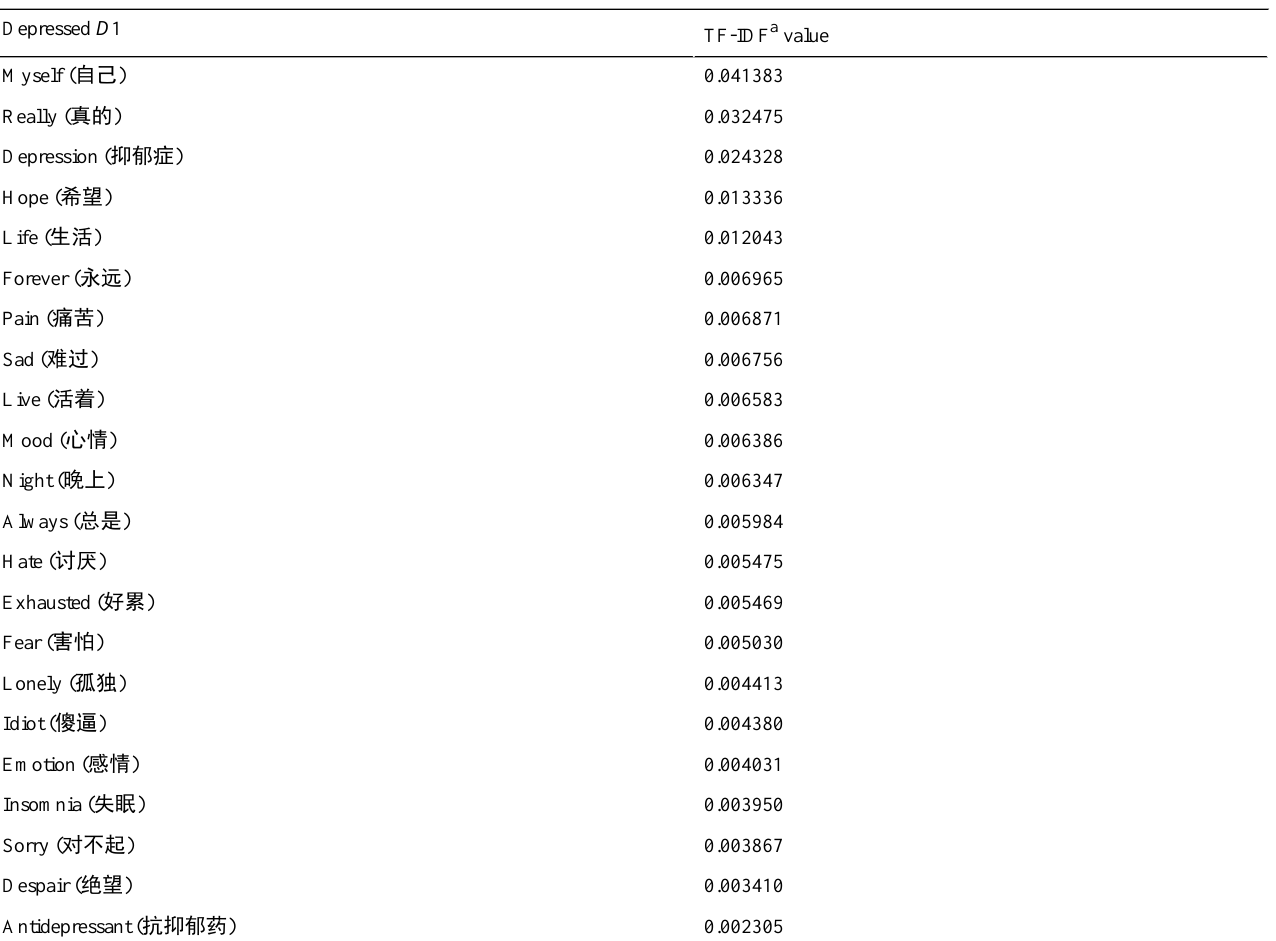
Table 2. TF-IDF values of depressed D1